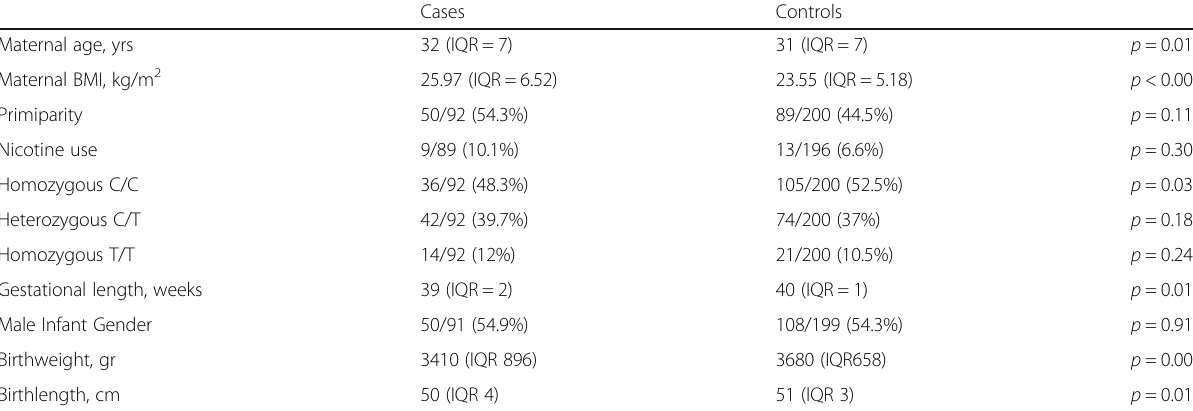
Table 1 Distribution of epidemiological data among cases and controls Cases